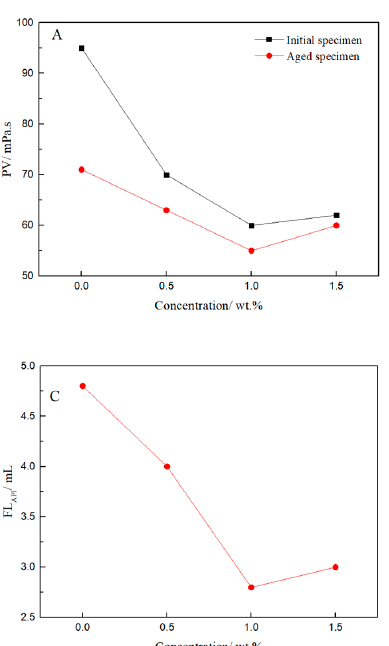
Figure 9. Effect of VR-H concentration on rheological and filtrate properties of the drilling fluid: ( A ) Plastic viscosity (PV), ( B ) Yield point (YP), ( C ) FL API of the drilling fluid after aging.